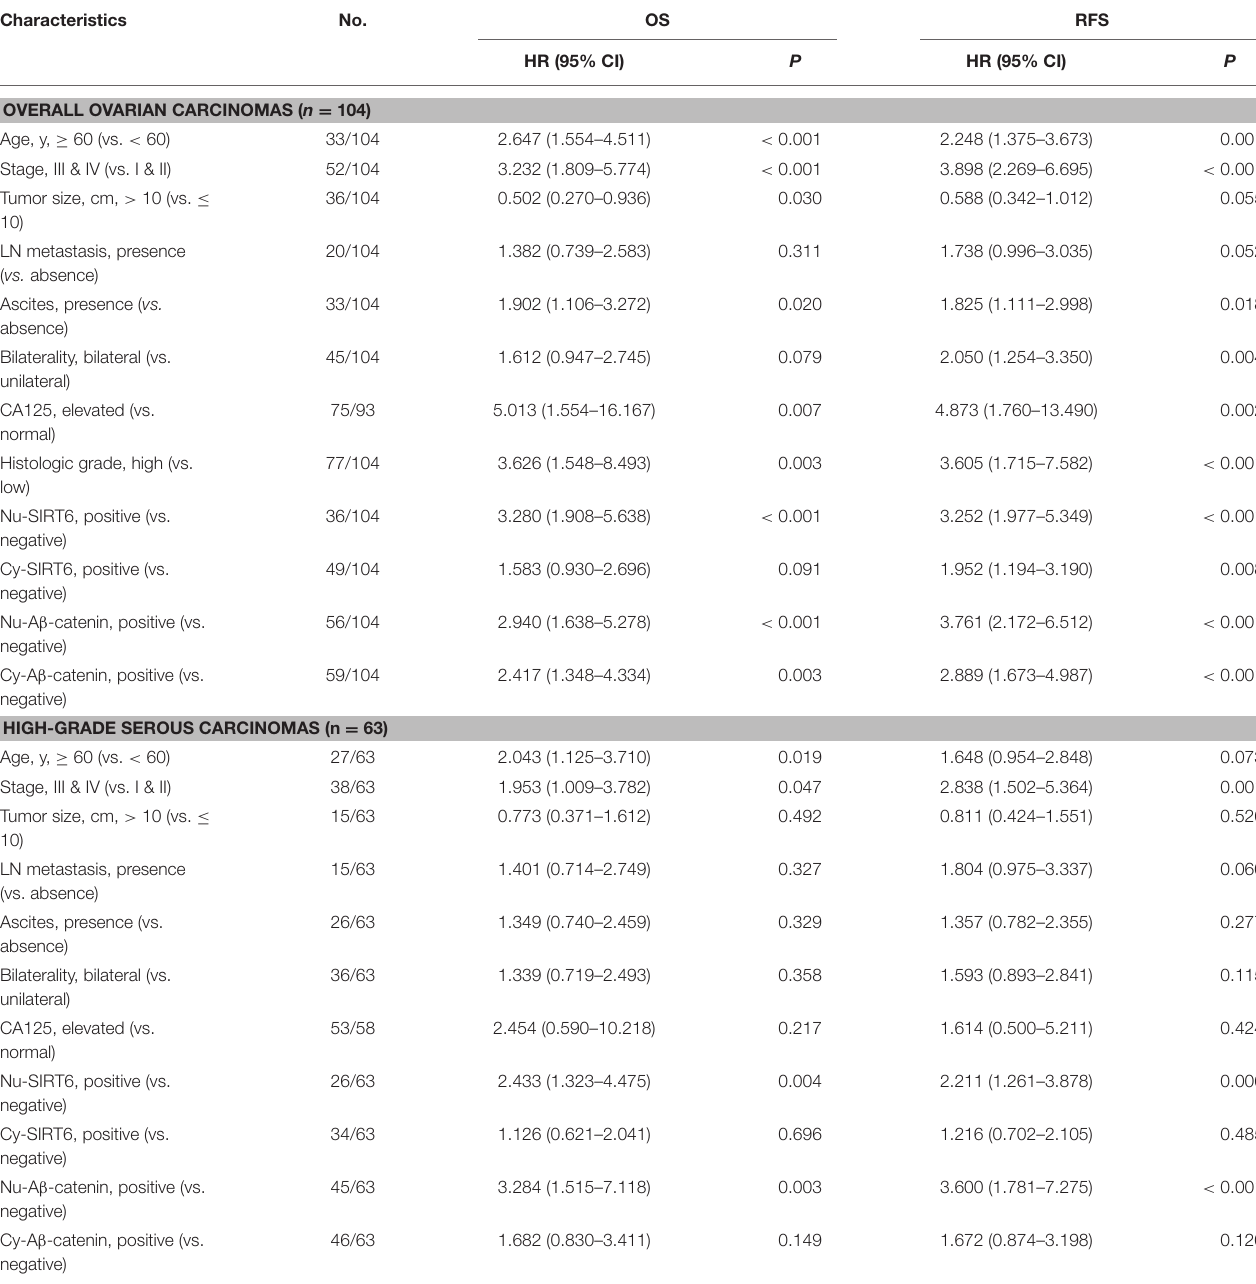
TABLE 3 | Univariate Cox regression analyses for overall survival and relapse-free survival in 104 ovarian carcinomas and 63 high-grade serous carcinomas. Characteristics